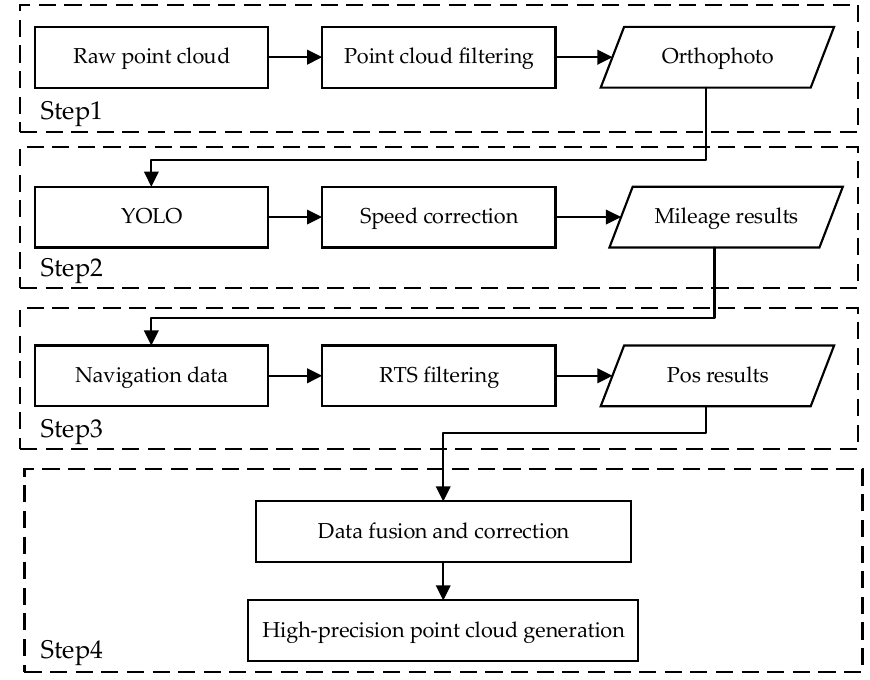
Figure 2. Flow chart of data processing of railway mobile laser scanning.